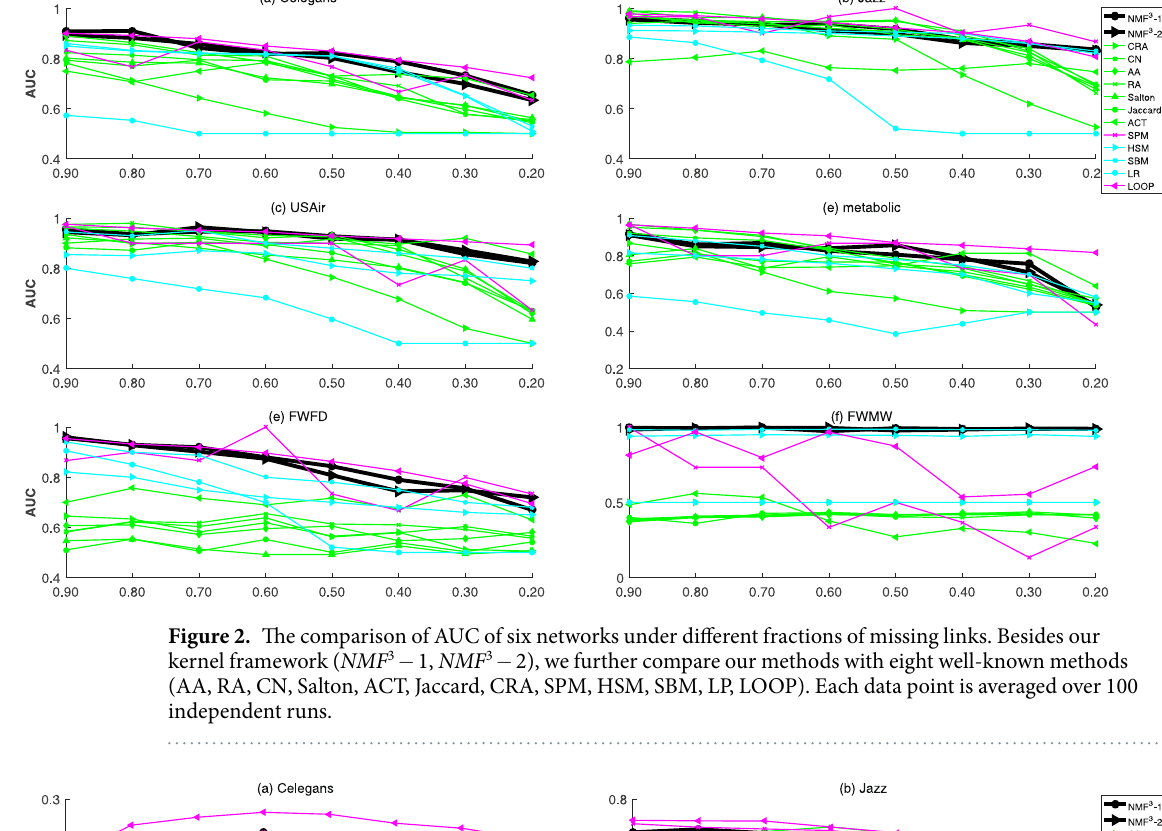
Figure 2. The comparison of AUC of six networks under different fractions of missing links. Besides our kernel framework ( NMF 3 − 1, NMF 3 − 2), we further compare our methods with eight well-known methods (AA, RA, CN, Salton, ACT, Jaccard, CRA, SPM, HSM, SBM, LP, LOOP). Each data point is averaged over 100 independent runs.